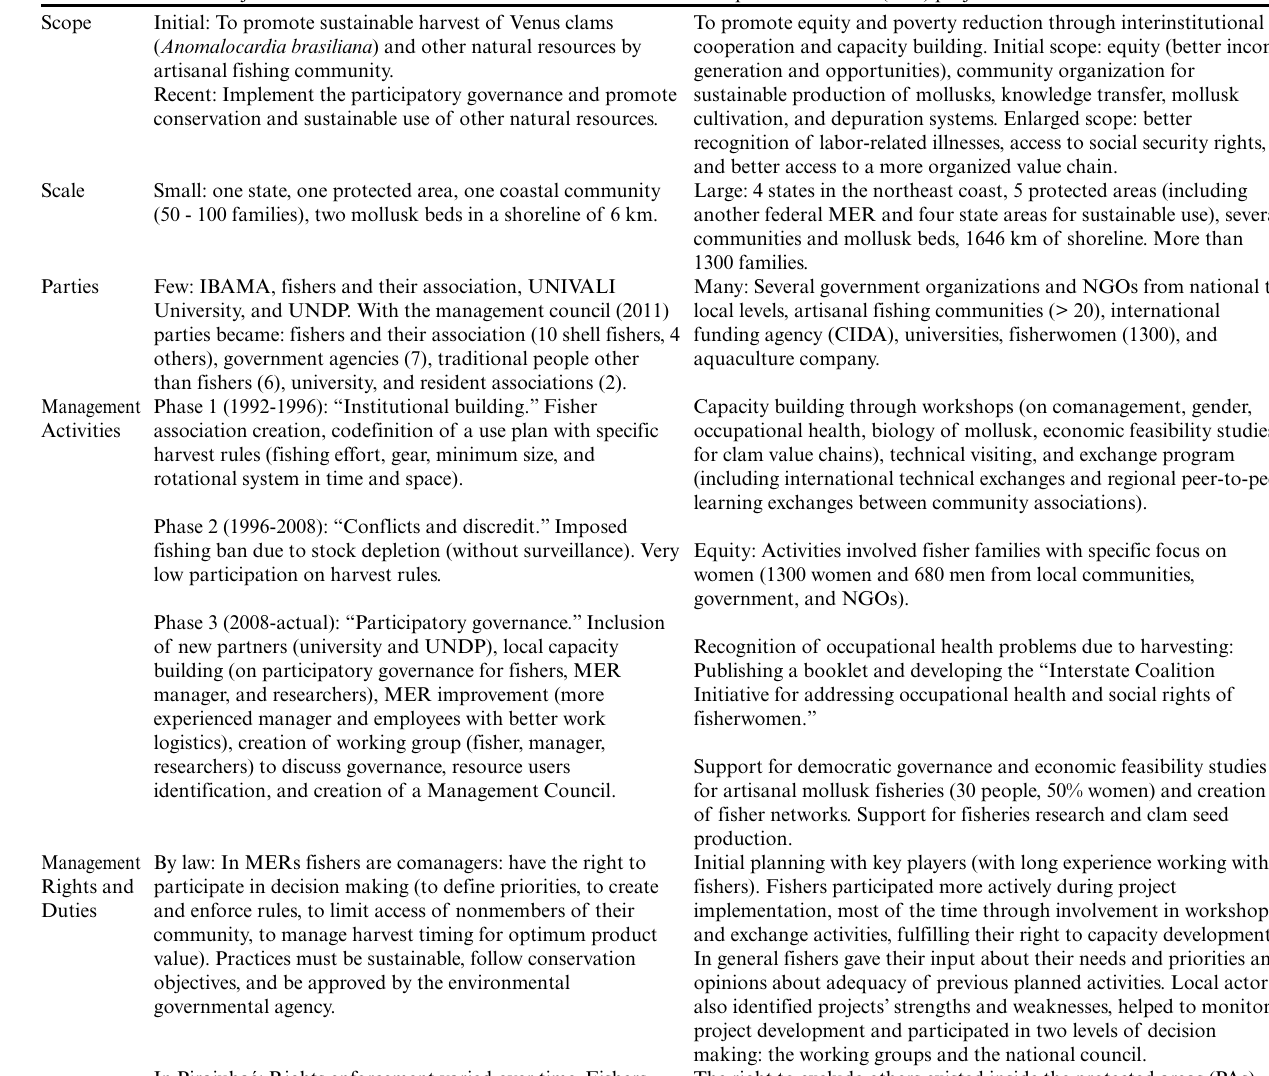
Table 1 . Comparison of institutional arrangements of clam comanagement initiatives in Marine Extractive Reserve Pirajubaé and “People of the Tides” project in Brazil. MER Pirajubaé “People of the Tides” (PoT)